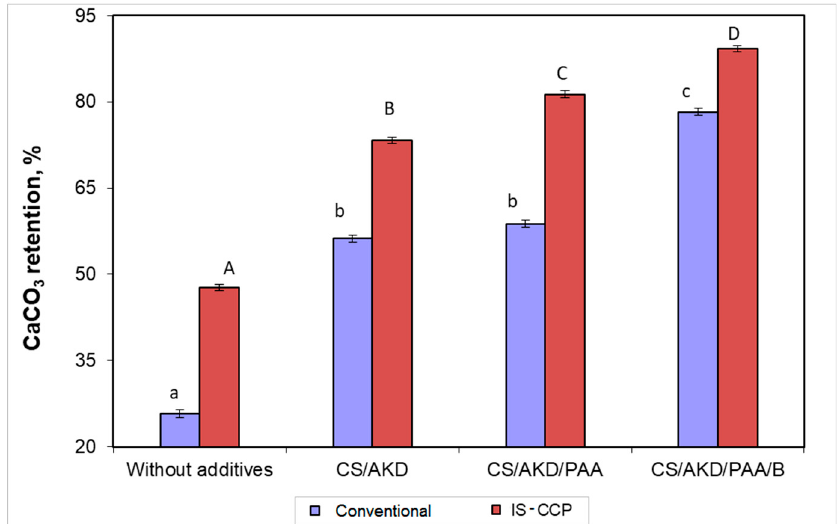
Figure 5. CaCO 3 retention for different additive systems in relation to paper composition. (different letters within the same method—small letters for conventional and capitals for IS-CCP designate statistical difference, p < 0.05).